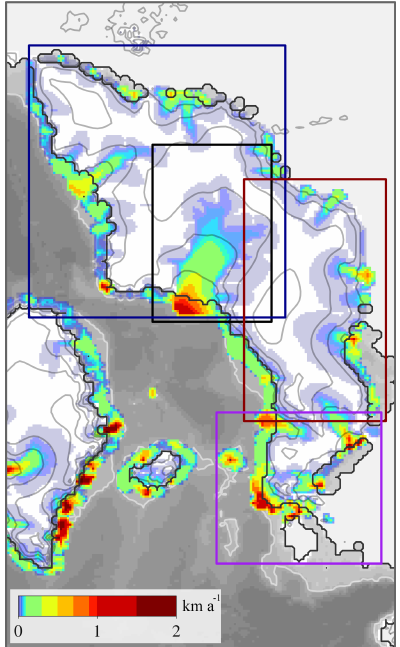
Figure 2. Resulting ice sheet of the MIS 3 control run (CTRL). Simulated ice thickness with contours plotted for every 500m. The grounding-line position is shown using a black line, the 500m depth contour is shown using a white line and velocities are shown us- ing the shaded colors (in kilometers per annum) after the spin-up was completed. This ice sheet represents the initial state previous to the application of perturbations. Bjørnøyrenna Basin, as referenced in the text, is shown using the black rectangle. The Barents–Kara, Scandinavian and British Islands regions are highlighted using blue, red and purple rectangles,